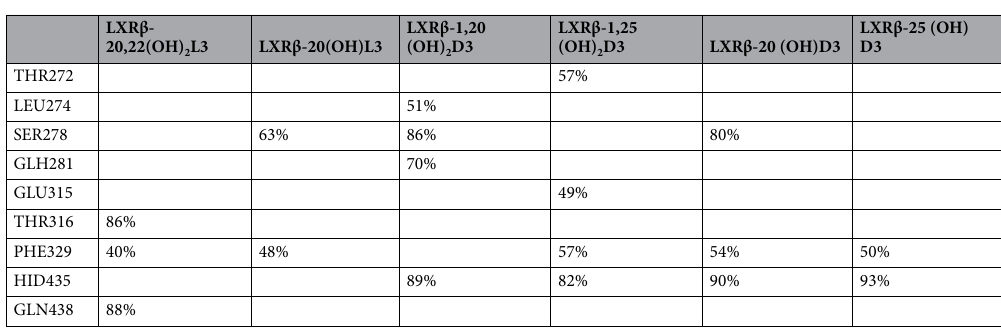
Table 6. Occupancy of hydrogen bond (no less than 40%) formed between LXRβ and D3 or L3